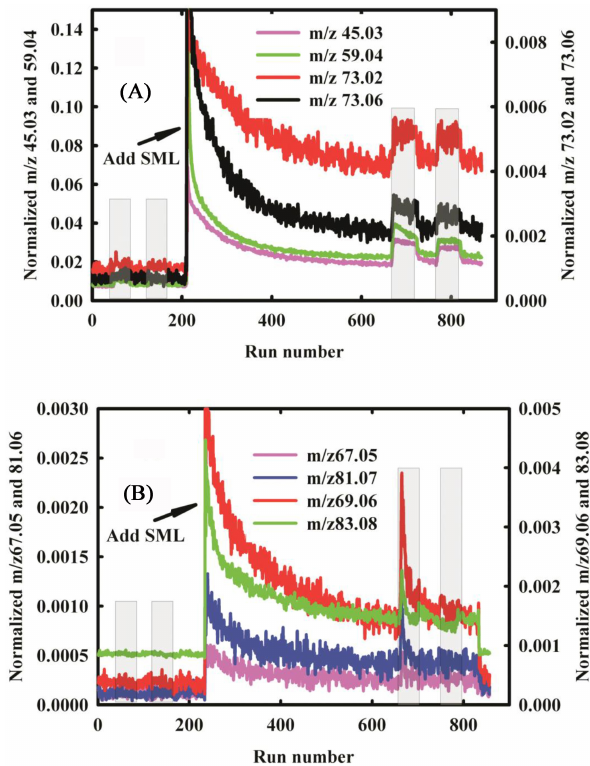
Fig. 10. Evolution of selected masses during oxidation of SML-CA with ozone. The shaded areas represent when ozone was present at